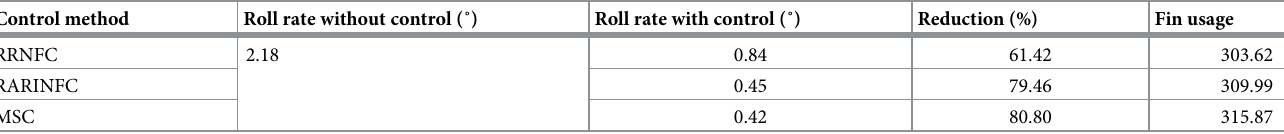
Table 3. Roll damping performance (simulation).